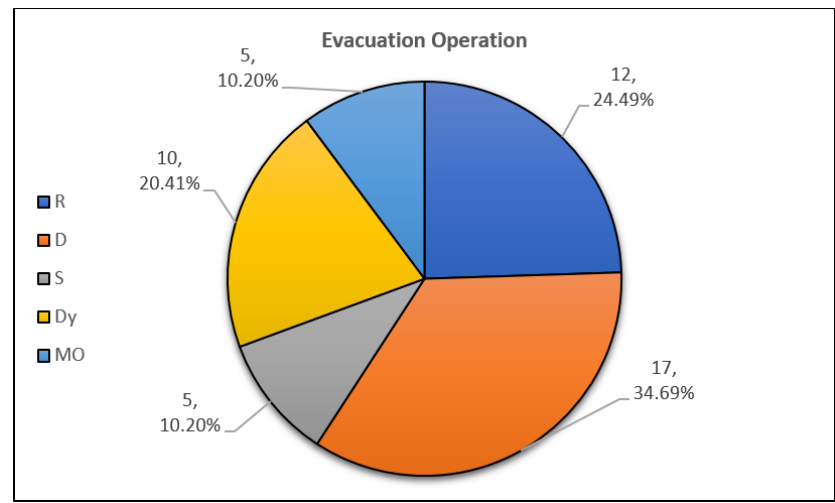
Figure 21. Breakdown of VRP for Evacuation Operation based on Modelling Aspect.